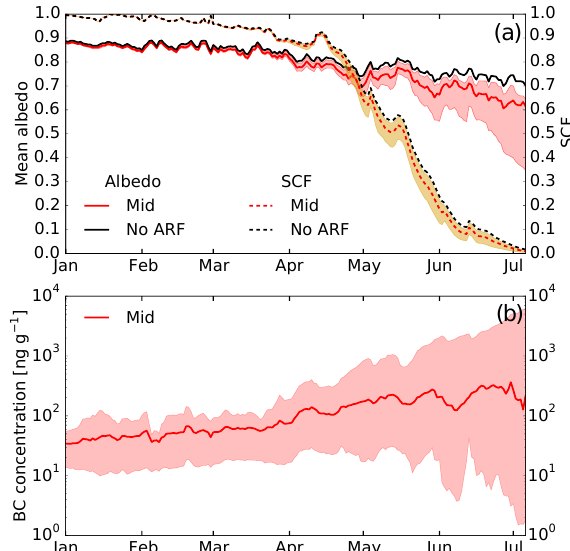
Figure 7. Catchment snow-covered fraction (SCF; dashed lines), (a) simulated mean radiative forcing in snow (RFS), and (b) total daily energy uptake in the catchment due to BC (surface radiative forcing in Watts per square metre catchment area) for the mid (solid red lines), min (lower bound of the shaded area), and max (upper bound of the shaded area) estimates averaged over the 6-year pe-